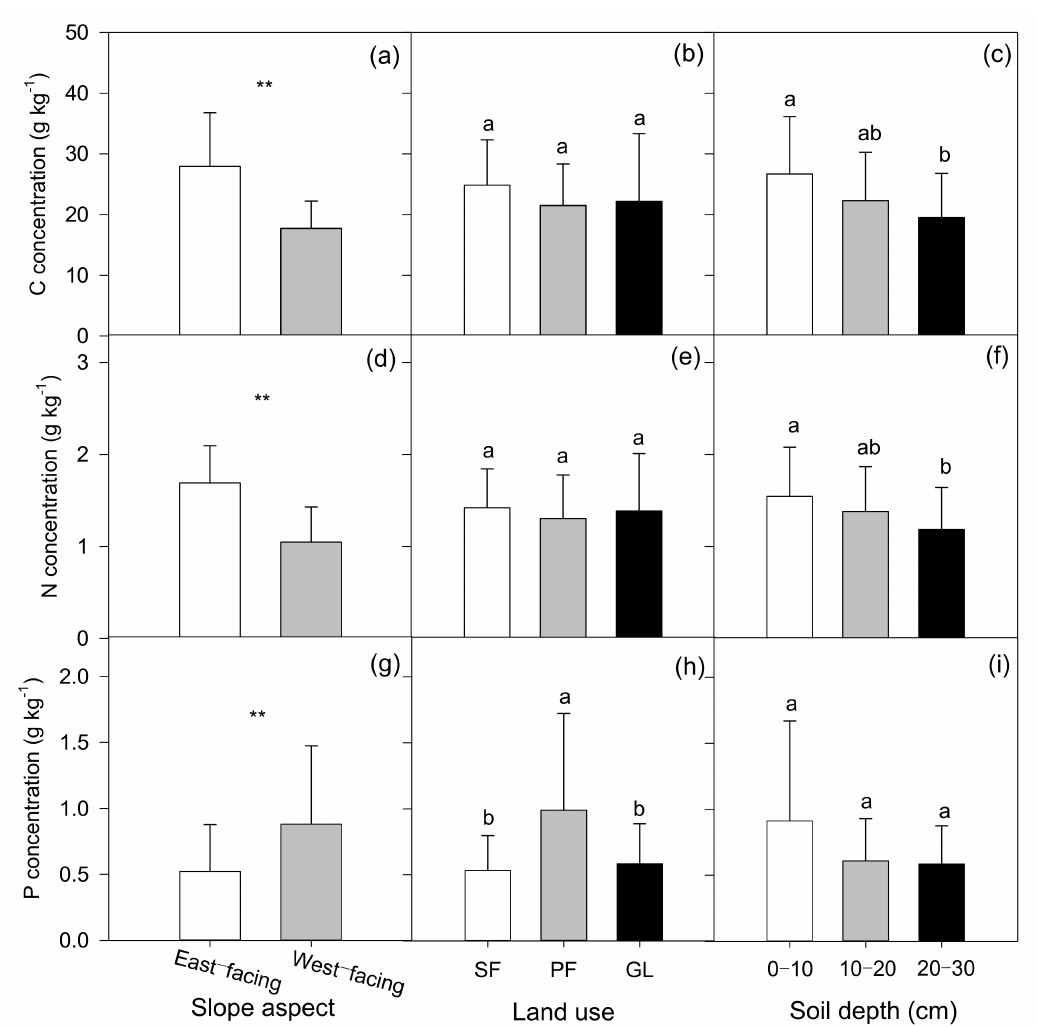
Figure 2. Soil C ( a – c ), N ( d – f ), and P ( g – i ) concentrations affected by slope aspect, land use and soil depth, respectively. Error bars represent standard deviation of means. “**” marked in the middle indicates significant difference between slope aspects. Different lowercase letters denote significant differences among land uses and soil depths, respectively. SF, secondary forest; PF, plantation forest; GL,